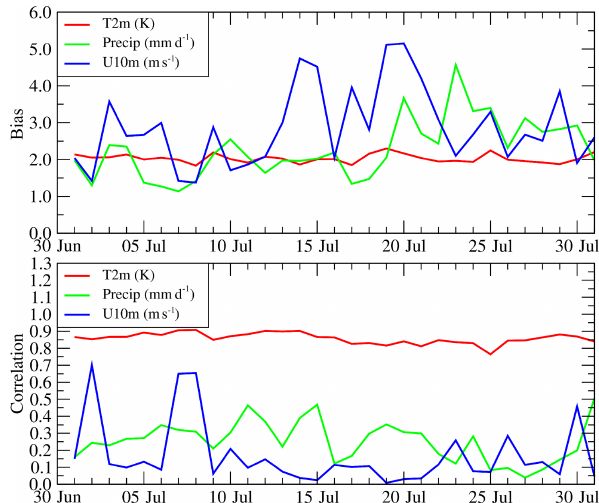
Figure 2. Time series of bias “CPLfull minus observations” and spatial correlation between CPLfull and observations for 2m tem- perature (K), 10m wind speed (ms − 1 ) and total (convective plus stratiform) precipitation rate (mmd − 1 ) for the month of July